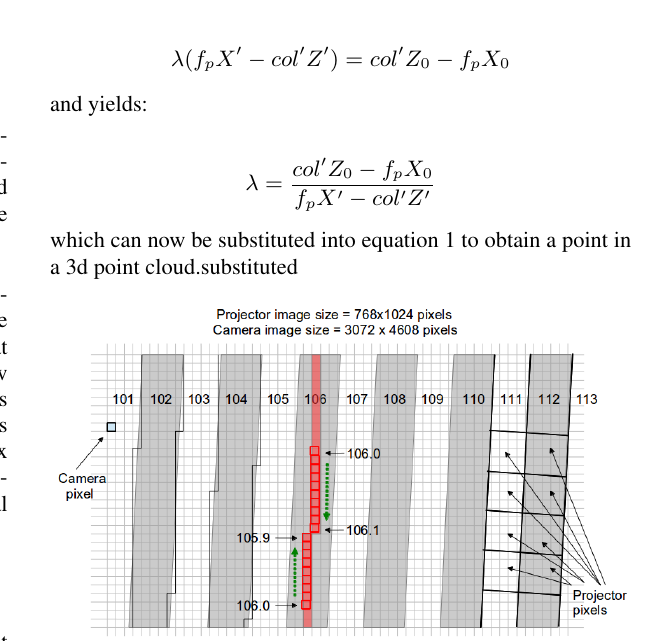
Figure 5: Spatial resolutions of camera and projector. The cam- era pixels indicated in red, at the centers of stripes in the pro- jected patters, are selected for further processing into the final point cloud. The corresponding projector column number is com- puted with sub-pixel